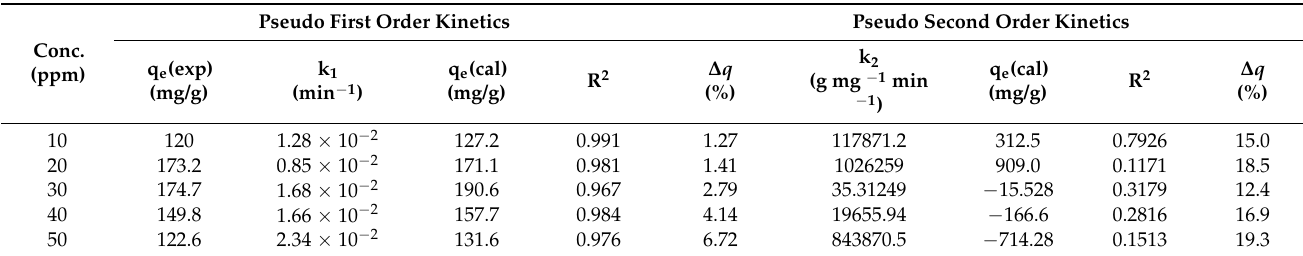
Table 1. Comparison of pseudo first order and pseudo second order for the adsorption of MB dye on adsorbent at different initial concentrations of dye.